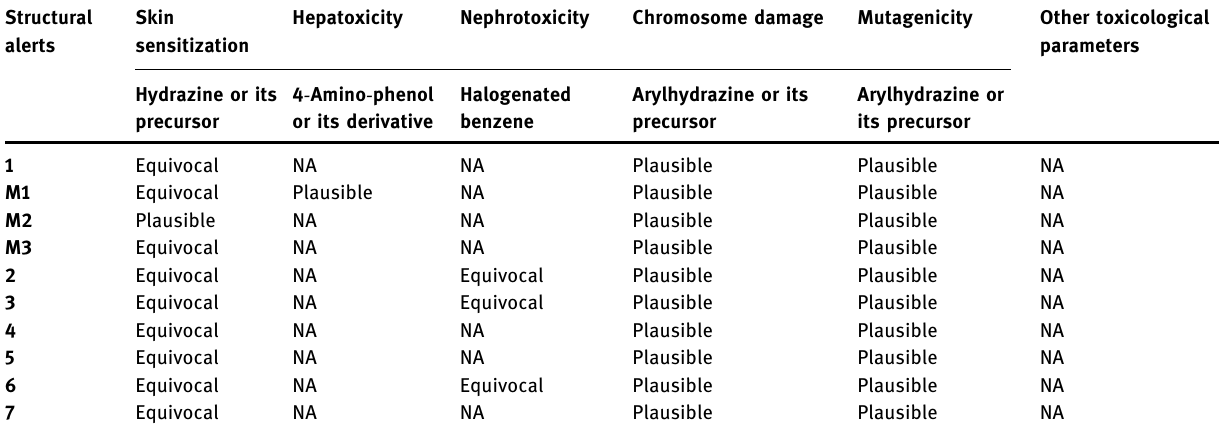
Table 3: Qualitative toxicity prediction of the compounds 1 – 7 and metabolites of compound 1 by DEREK analysis Structural